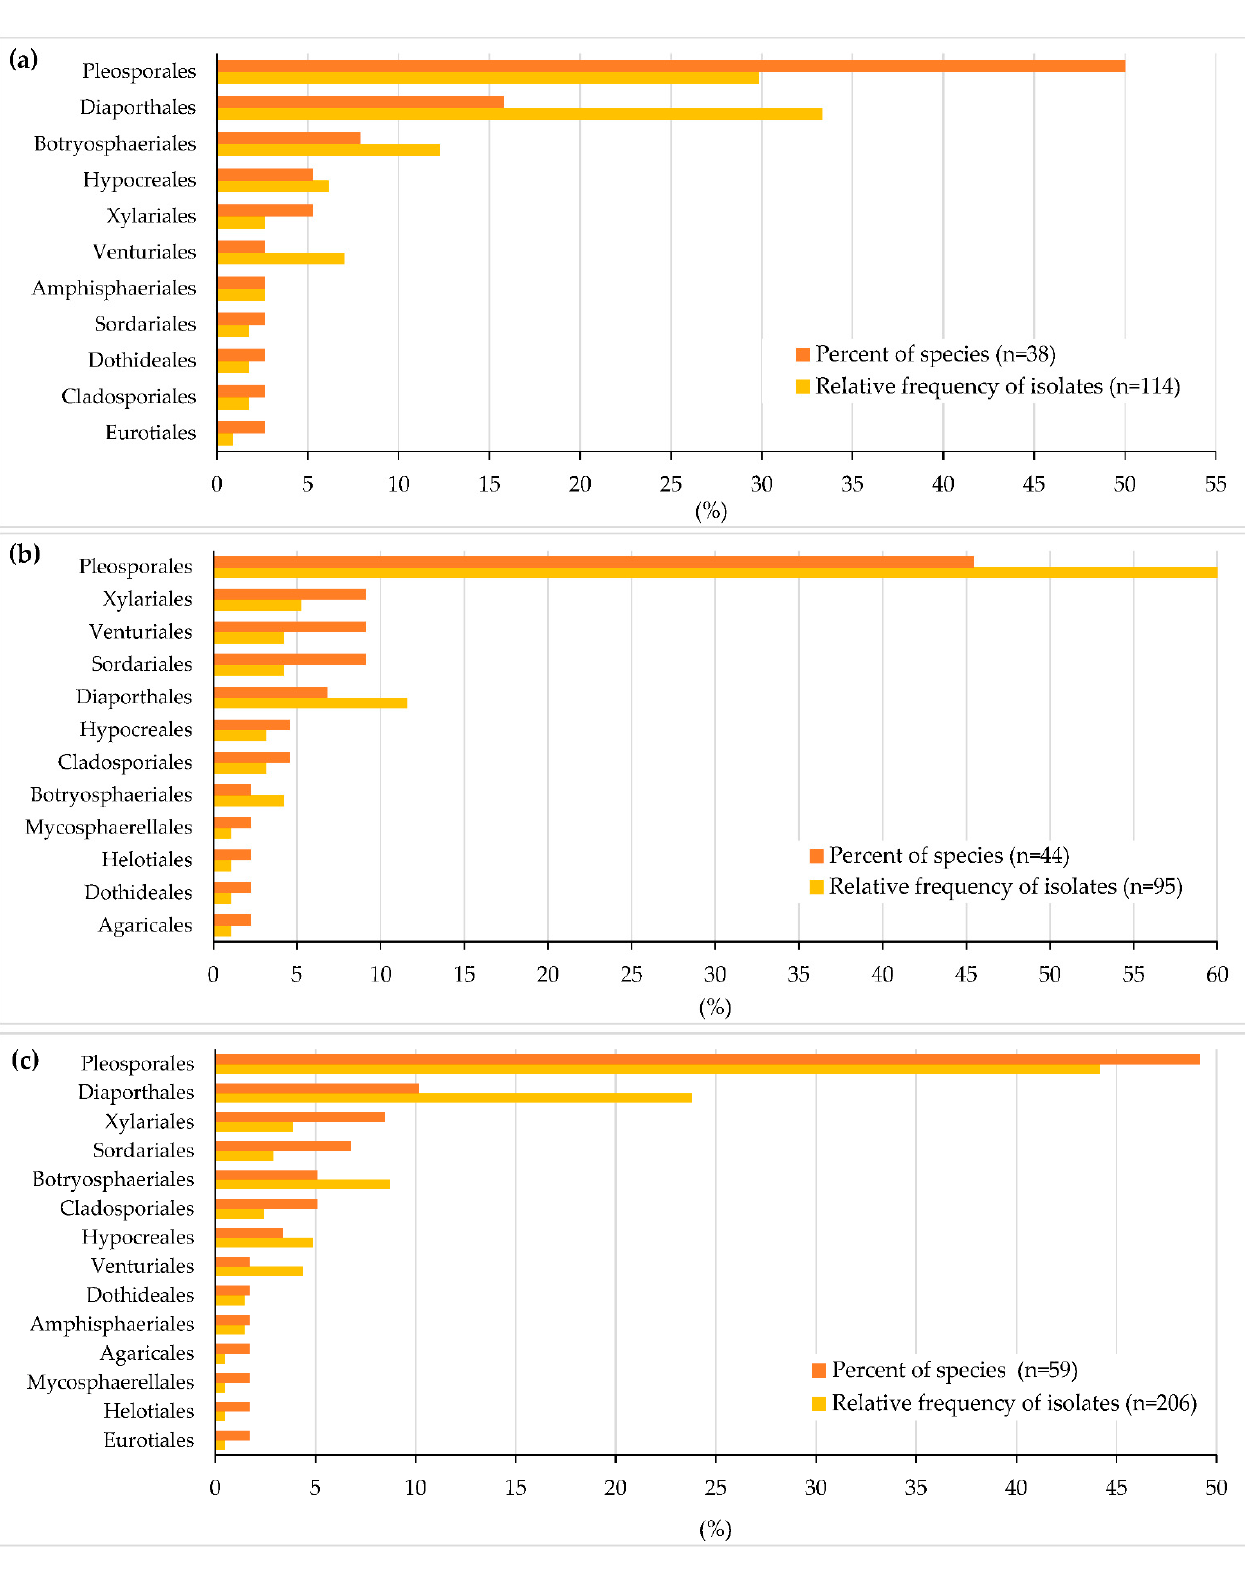
Figure 3. Relative frequency of isolates by taxonomic order and percentage proportions of species number in a particular order to the overall number of isolated species; ( a ) analysis of isolates from May 2019; ( b ) analysis of isolates from October 2019; ( c ) total number of isolates in 2019.